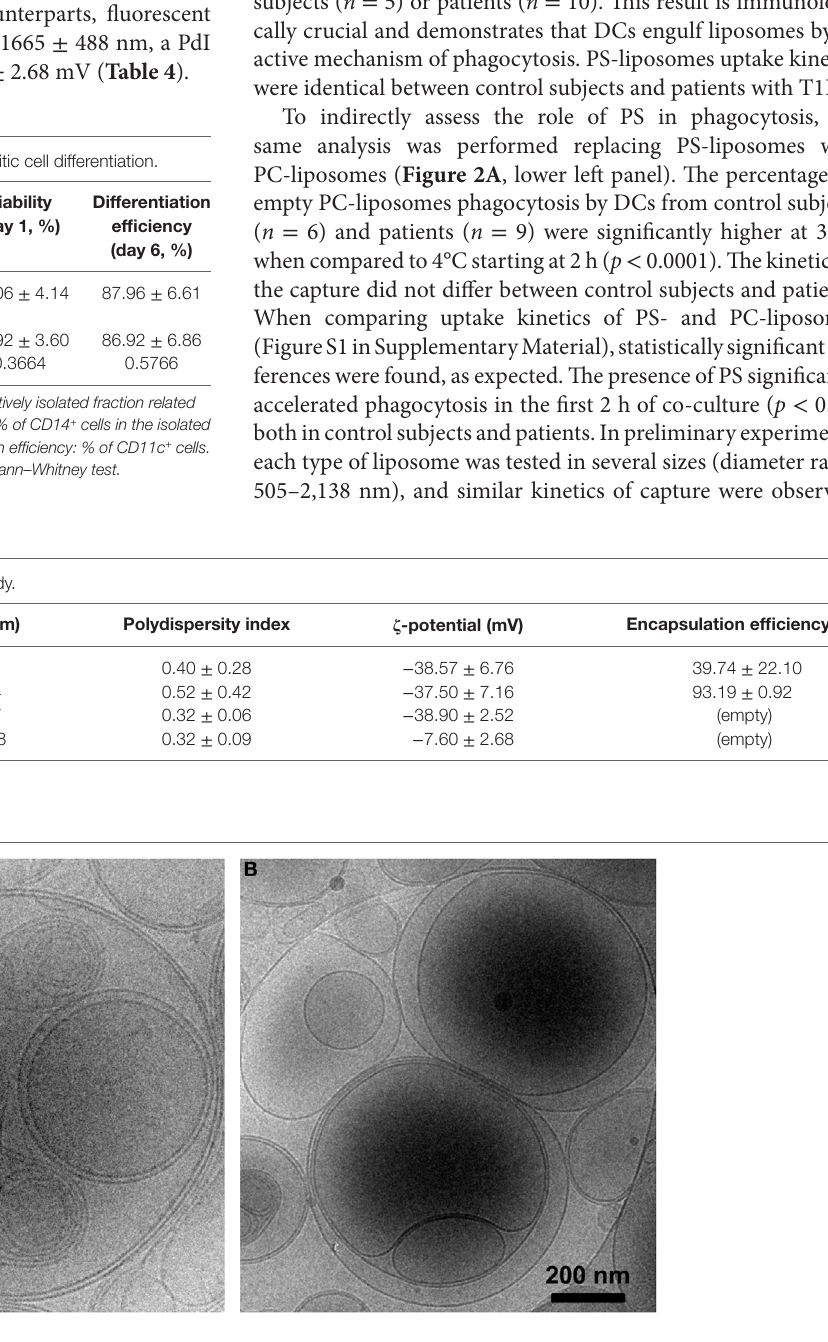
FigUre 1 | PS-liposomes display multivesicular and multilamellar morphology. Cryogenic transmission electron microscopy images of (a) PSA-liposomes (left) and (b) PSB-liposomes (right). Bar = 0.2 μ m.